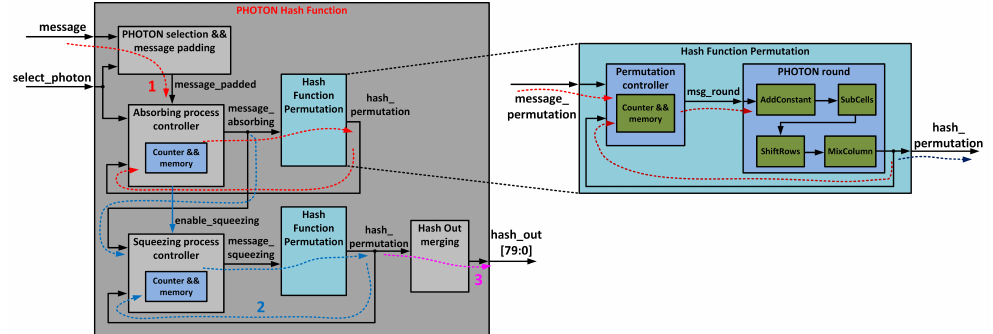
Figure 10. Hardware architecture of PHOTON.